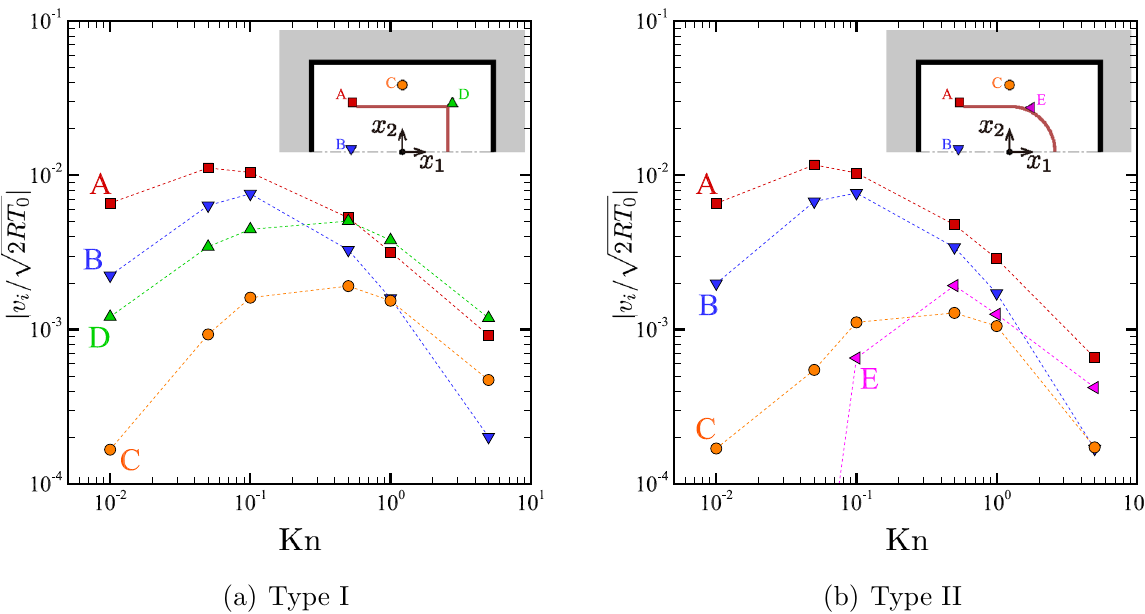
( v 2 ) 1 / 2 versus Kn at a given location in the gas in the v i v 2 1 + 2 | | =